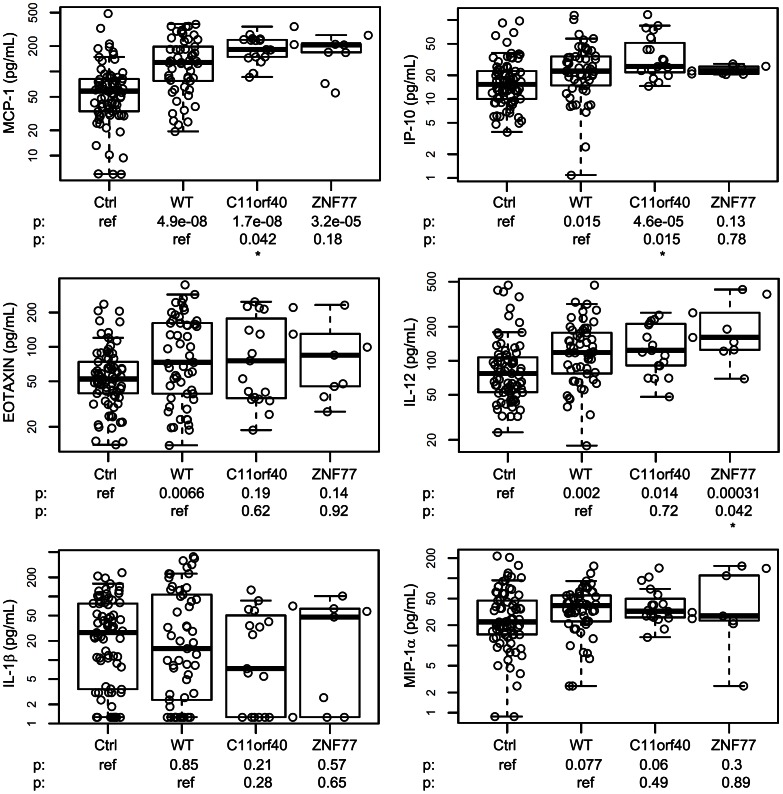
Plasma chemokine/cytokine levelsin FMS patients with C11orf40 or ZNF77 mutations.Ctrl: unrelated healthy controls, n = 77 (female = 48 and male = 29). WT: FMS patients with wild type (non-variant) C11orf40 and ZNF77, n = 53 (female = 45 and male = 8). C11orf40: FMS patients with C11orf40 mutation W32X, n = 20 (female = 13 and male = 7). ZNF77: FMS patients with ZNF77 mutation Q100X, n = 9 (female = 7 and male = 2). P values in the first row are in comparison with unrelated healthy controls; P values in the second row are in comparison with wild type (non-variant) C11orf40 and/or ZNF77 genes.Discovery of Potential New Gene Variants and Inflammatory Cytokine Associations with Fibromyalgia Syndrome by Whole Exome Sequencing.